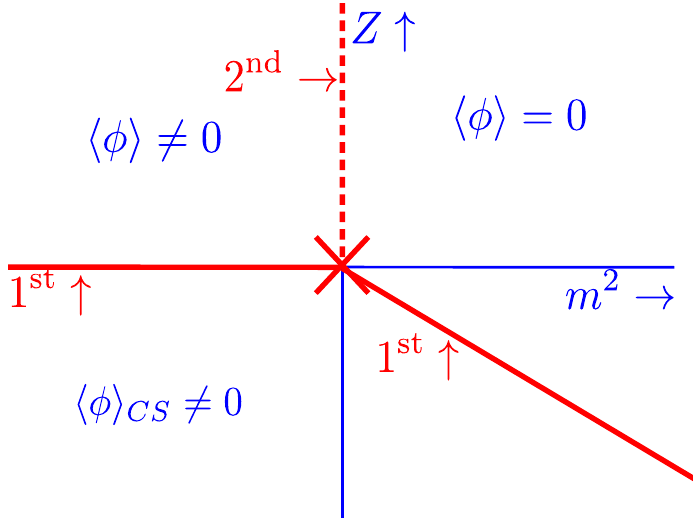
Figure 4. The phase diagram for a theory where Z can be of either sign, corrected for anisotropic fluctuations. The three phases meet at the Lifshitz